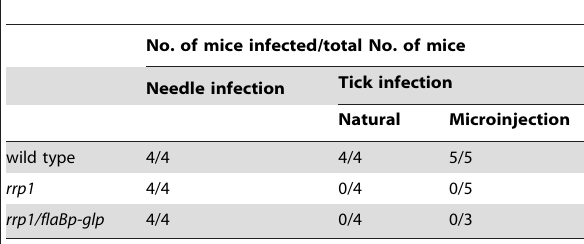
Table 6. Mouse infectivity of the rrp1 mutant with constitutive expression of